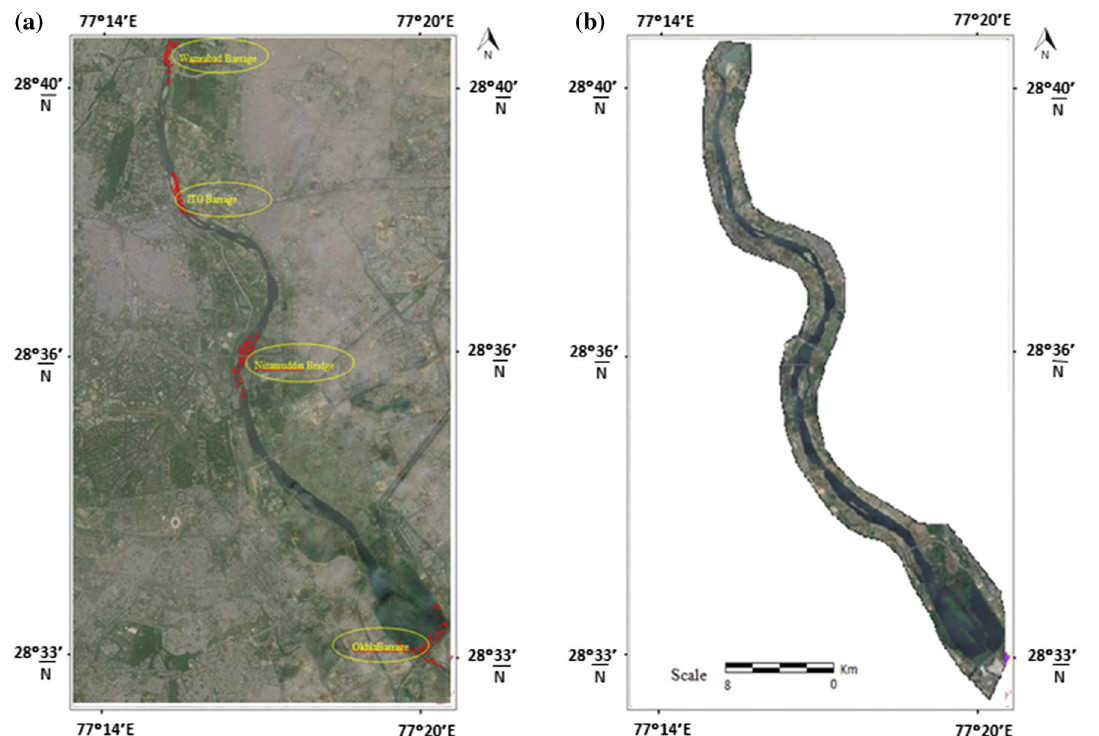
Fig. 2 a GeoEye-2 image of the study area depicting sampling locations marked with red dots. b Subset image of the study